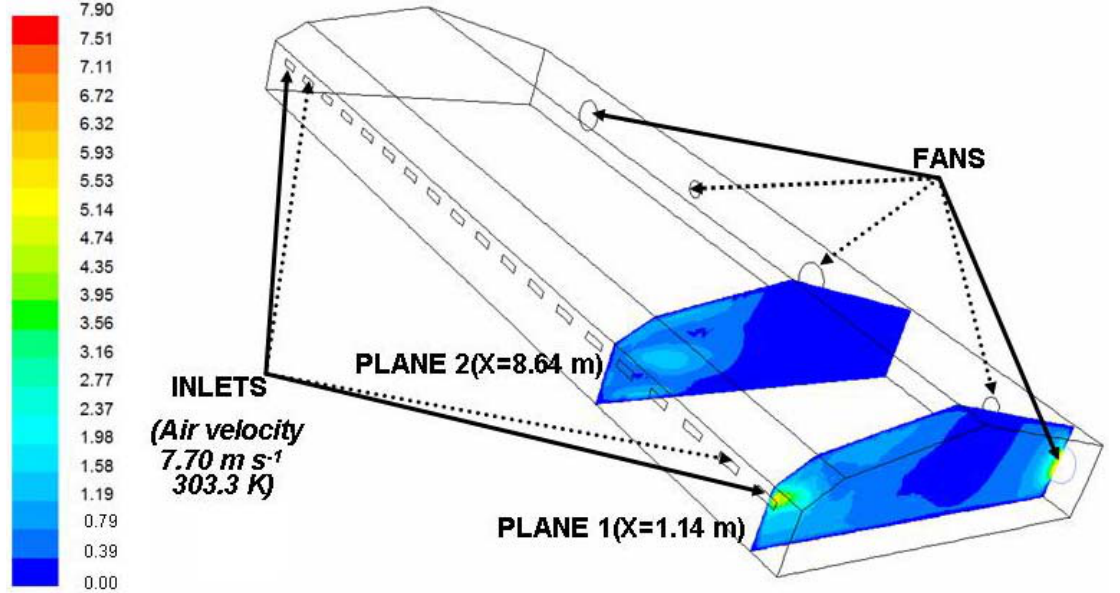
Figure 3. Contours of air velocity in Planes 1 and 2 of the Section A in a trial scenario (Scenario II). Air velocity is expressed in m s − 1 .